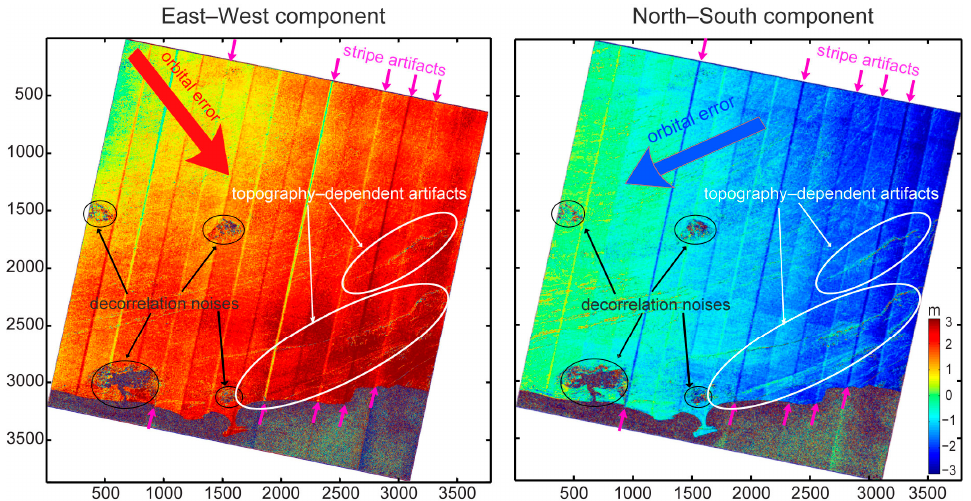
Figure 3. Error sources in E/W and N/S components of image deformation field, selecting the correlation image pair 29 November 2013–15 December 2013 as an example. We can see there are obvious orbital error, decorrelation noises, topography-dependent artifacts, and stripe artifacts in image deformation field.